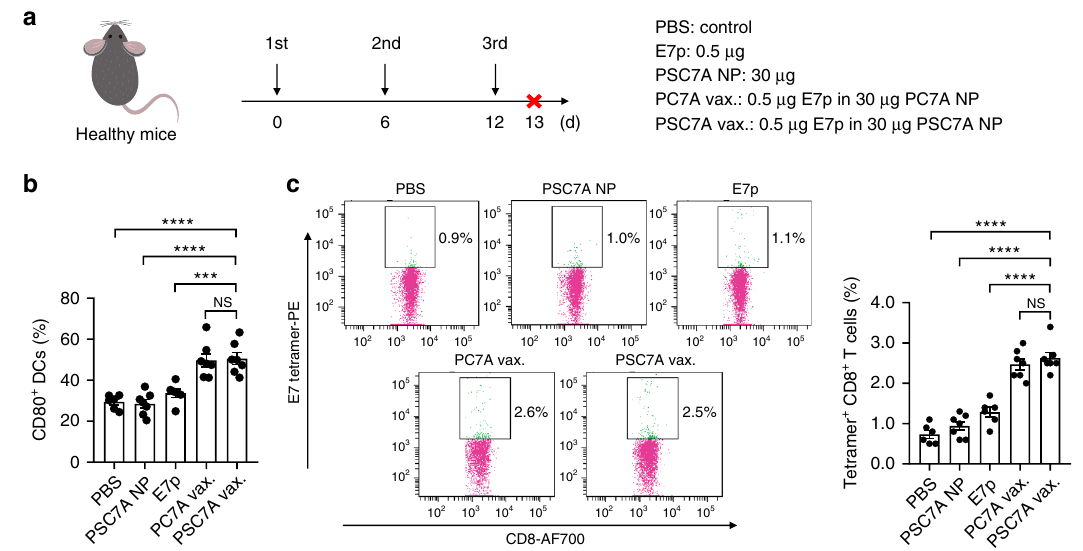
Fig. 3 PSC7A nanovaccine increases the percentage of CD80 + dendritic cells and tetramer + CD8 + T cells in vivo. a C57BL/6 healthy mice were treated with PBS, E7p, PSC7A NP, and PC7A vaccine (PC7A vax.) or PSC7A vaccine (PSC7A vax.) three times in 6 day intervals. One day after the last administration (on day 13), the mice were sacri fi ced and lymph nodes were harvested for fl ow cytometry analysis. b Summary of percentage of CD80 + DCs in inguinal lymph nodes 1 day after the last administration. n = 6 biologically independent mouse samples in each PBS and E7p group. n = 7 biologically independent mouse samples in each PSC7A NP, PC7A vaccine, and PSC7A vaccine group. Data are presented as means ± s.e.m. and statistical signi fi cance was calculated using Student ’ s two-tailed t -test (PSC7A vax. vs. E7p: *** P = 0.0008, PSC7A vax. vs. PSC7A NP: **** P < 0.0001, PSC7A vax. vs. PBS: **** P < 0.0001). c Representative fl ow dot plots of E7 tetramer staining of CD8 + T cells in lymph nodes and summary of percentage of E7 tetramer + CD8 + T cells measured by fl ow cytometry. n = 6 biologically independent mouse samples in each PBS and E7p group. n = 7 biologically independent mouse samples in each PSC7A NP, PC7A vaccine, and PSC7A vaccine group. Data are presented as means ± s.e.m. and statistical signi fi cance was calculated using Student ’ s two-tailed t test (PSC7A vax. vs. E7p: **** P < 0.0001, PSC7A vax. vs. PSC7A NP: **** P < 0.0001, PSC7A vax. vs. PBS: **** P <